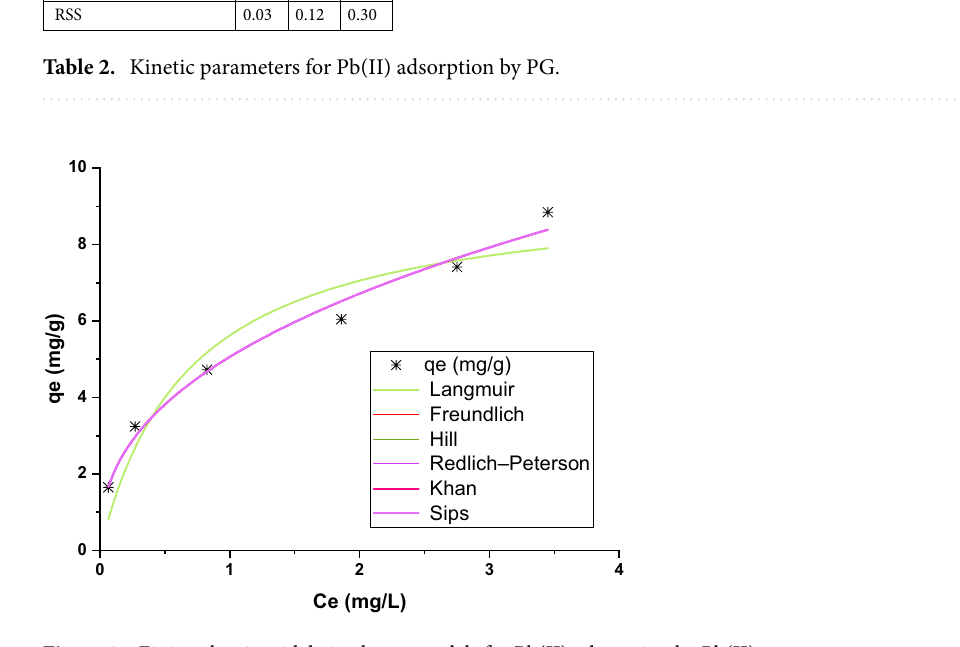
Figure 9. Fitting the six widely isotherm models for Pb(II) adsorption by